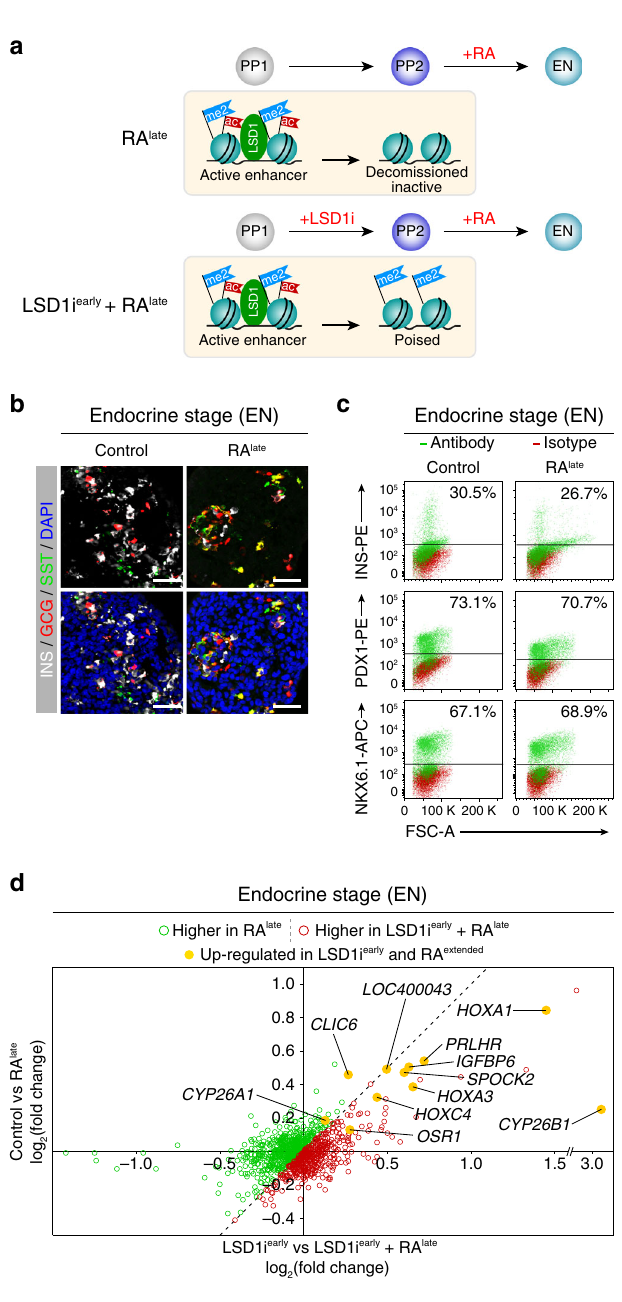
Fig. 9c – e). Analysis of the endocrine progenitor marker Ngn3 further revealed that endocrine lineage commitment was unaf- fected in Lsd1 Δ pan embryos (Fig. 6b, c). Thus, as in the hESC differentiation system, Lsd1 inactivation in early pancreatic pro- genitors of mice prevents endocrine cell differentiation after endocrine fate commitment.